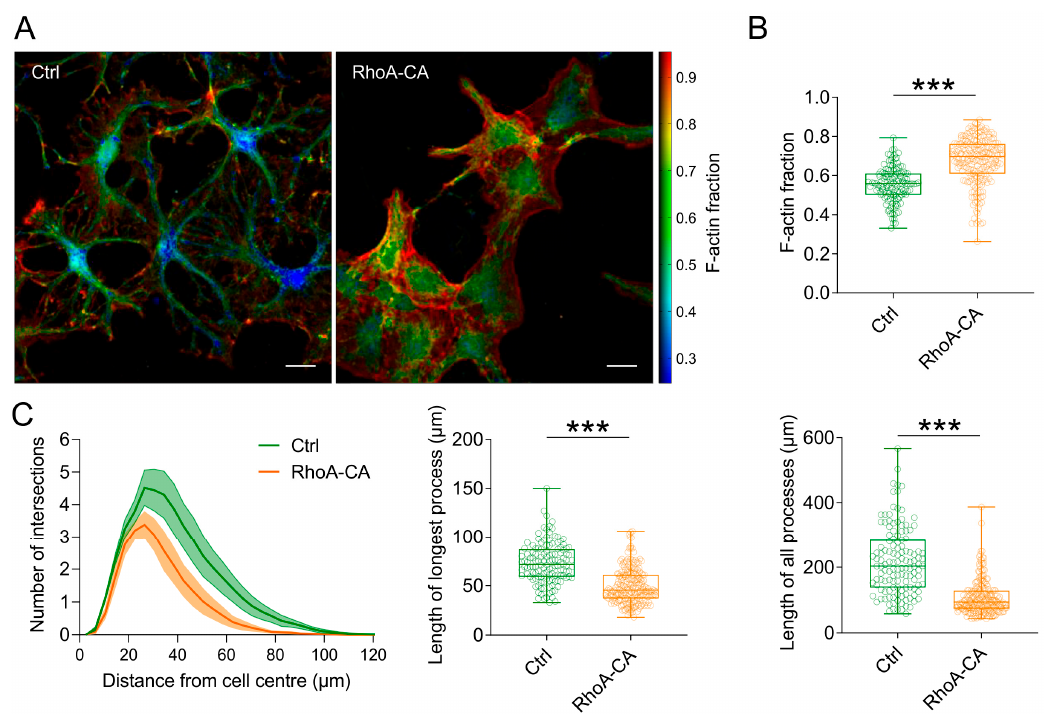
Figure 2. Astrocytic expression of RhoA-CA increases the F-actin fraction in vitro. ( A ) Representa- tive images of cultured mouse hippocampal astrocytes expressing tdTomato (Ctrl, AAV-hGFAP- tdTomato) or RhoA-CA and tdTomato (AAV-hGFAP-tdTomato-RhoA-CA) stained for filamentous and globular actin structures (F-/G-actin). Displayed is the color-coded F-actin fraction (F-actin/(F- actin + G-actin)) (scale bars 20 μ m). ( B ) Increased F-actin fraction in astrocytes expressing RhoA-CA (0.67 ± 0.12) compared to control cells (0.55 ± 0.09, Mann–Whitney U-test, p < 0.001). ( C ) Sholl anal- ysis shows a reduced number of processes, defined by the number of intersections, in astrocytes expressing RhoA-CA. Area under the curve (AUC, left panel) was reduced in RhoA-CA (AUC 105 ± 8.4) compared to the control experiments (AUC 186 ± 12.1; unpaired Student’s t -test, p = 0.0015). Overexpression of RhoA-CA reduced the mean length of the longest processes (middle panel; Ctrl: 73.3 ± 20.6 μ m; RhoA-CA: 49.6 ± 17.5 μ m; Mann–Whitney U test, p < 0.001) and the total length of all processes (right panel; Ctrl: 219.0 ± 103.0 μ m; RhoA-CA: 108.1 ± 52.4 μ m; Mann–Whitney U test, p < 0.001). For ( B , C ), four independent cultures were analysed (Ctrl: n = 132 cells; RhoA-CA: n = 210 cells). Box and Whisker plots: box indicates the 25th and 75th percentiles, the whiskers the minimum and maximum values, the horizontal line in the box the median, and hollow circles on top the indi- vidual data points. *** indicates p ≤ 0.001.